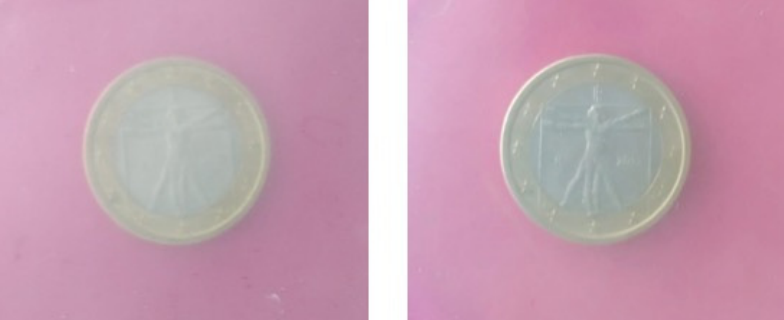
Figure 3. Pictures of PBCE homopolymer ( left ) and P(BCE 85 BC 15 ) copolymer ( right ). Table 2. Thermal (TGA and DSC) and structural (WAXS) characterization data of PBCE and P(BCE x BC y ) copolymers.